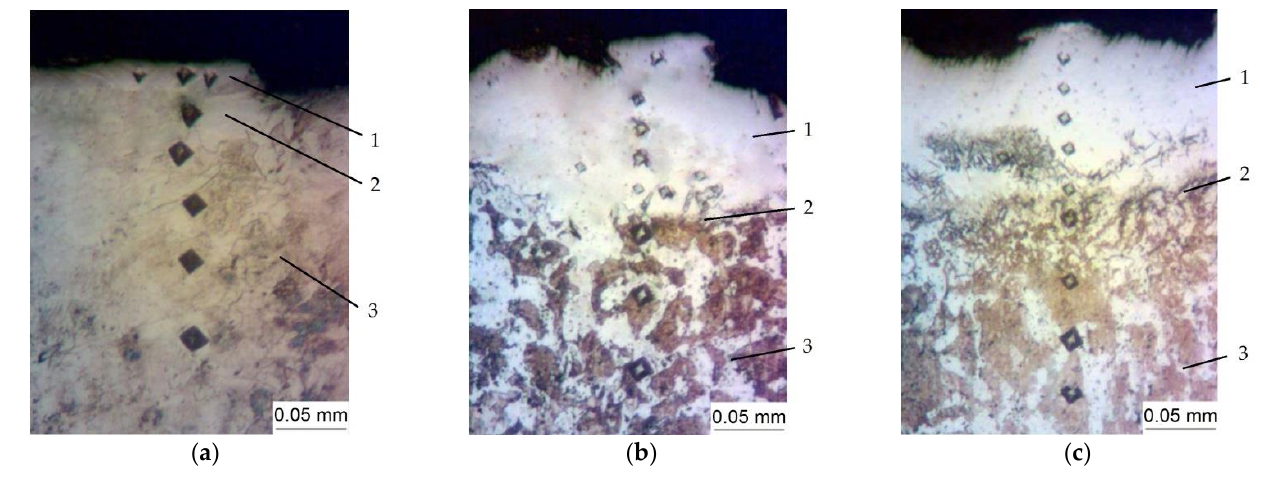
Figure 4. The microstructures of the nitrocarburized surface layers of the specimens made of steel C40 with the aluminum sublayers and processed with the use of the ESA method by the electrode-tool of steel C40 at the discharge energy (W р ): ( a ) — W р = 0.13; ( b ) — W р = 0.52 and ( c ) — W р = 3.40 J, 1 —” white layer ” , 2 — the diffusion zone, 3 — the base metal.